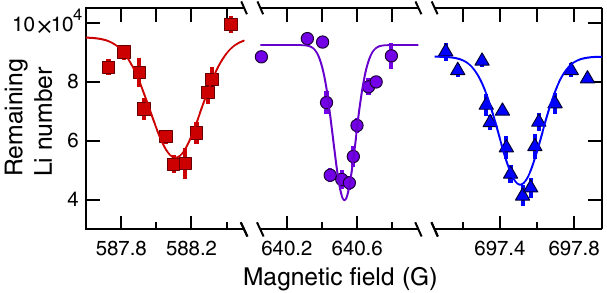
FIG. 3. Dependence of magnetic Feshbach resonances on the 173 Yb nuclear Zeeman state in a 173 Yb- 6 Li mixture seen in the FIG. 2. Observation of interspecies 173 Yb 6 Li magnetic remaining 6 Li atom number as functions of B near the 640 G Feshbach resonances as functions of magnetic field B . Feshbach resonance. 6 Li is prepared in hyperfine state Resonances appear as B -dependent atom loss. The 6 Li atom loss j m s; Li ; m i; Li i ¼ j − 1 = 2 ; 0 i and the 173 Yb sample is spin polarized is shown after the 2 . 8 μ K mixture has been held for 3 s in the dipole trap. Red squares, purple circles, and blue triangles in different nuclear Zeeman states. The data are normalized by the − 1 = 2 ; 1 i , ; m correspond to data for 6 Li in states j m remaining 6 Li atom number away from resonance and vertically s; Li i; Li i ¼ j offset for clarity. The distance between vertical tick marks is one. j − 1 = 2 ; 0 i , and j − 1 = 2 ; − 1 i , respectively. The nuclear Zeeman 5 = 2 i in each case. From top to bottom 173 Yb is prepared in nuclear spin state state of 173 Yb is spin polarized to j m i; Yb i ¼ j þ − 5 = 2 , − 3 = 2 , − 1 = 2 , þ 1 = 2 , þ 3 = 2 , and þ 5 = 2 . No m Each point is the average of at least four measurements and the i; Yb ¼ − 5 = 2 . The temperature is 1 . 8 μ resonance exists for m error bars are one-standard-deviation statistical uncertainties. i; Yb ¼ Curves are best-fit Gaussians and only meant as a guide to the eye. Our full line shape analysis is found in Sec. VII.